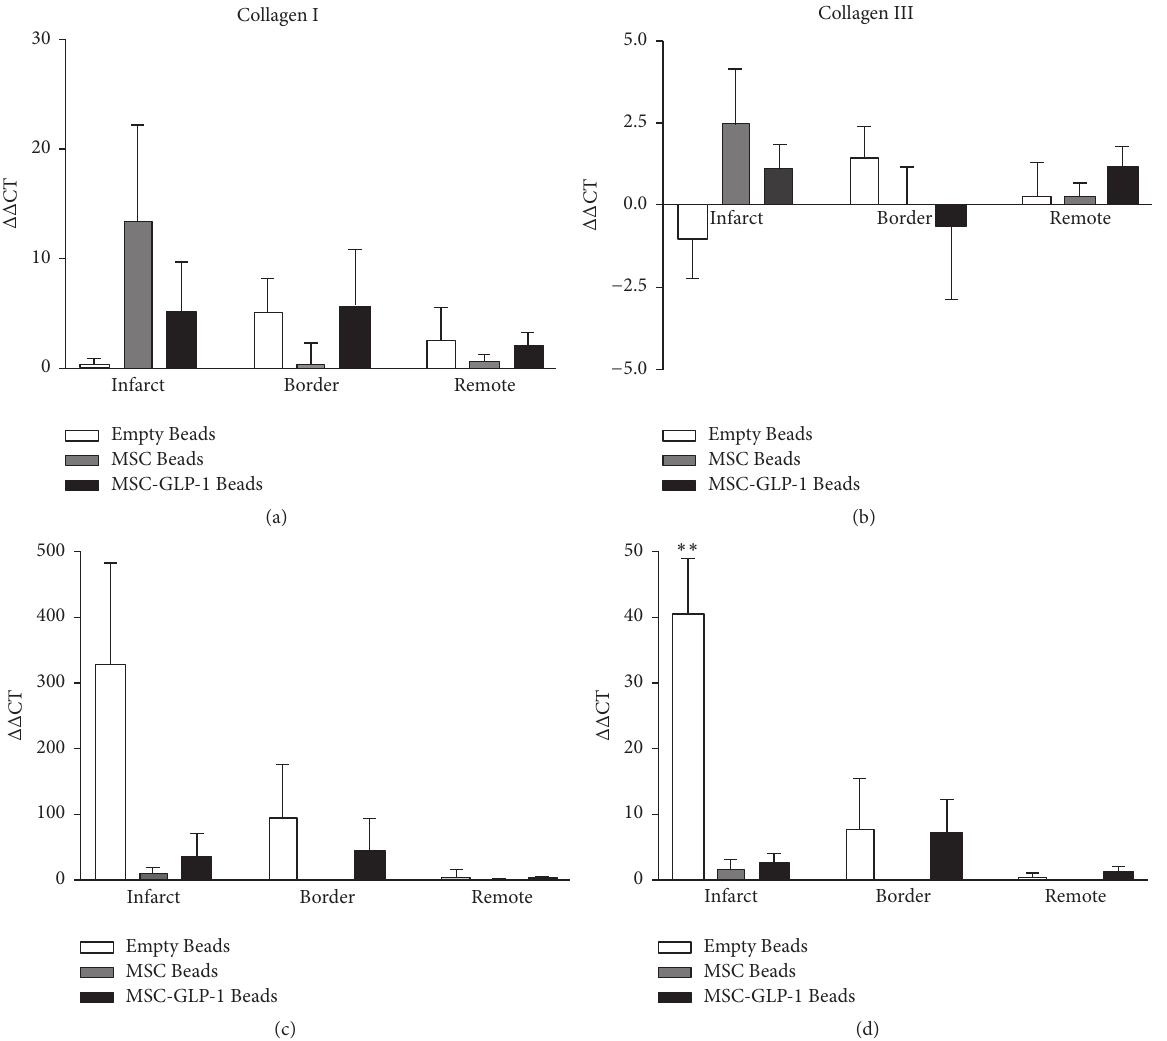
Figure 2: Quantification of collagen I and collagen III mRNA levels. No significant differences were observed between collagen I (a) and collagen III (b) mRNA levels within myocardium from infarct, border, and remote zones at one week after MI. At four weeks after MI, large increases in collagen I (c) and collagen III (d) mRNA levels were observed in the Empty Bead group in both infarct and border regions and this was significantly higher than the CellBead-MSC and CellBead-MSC + GLP-1 treated groups for collagen III. 𝑁 = 3 – 5 per group; 𝑃 < 0.01